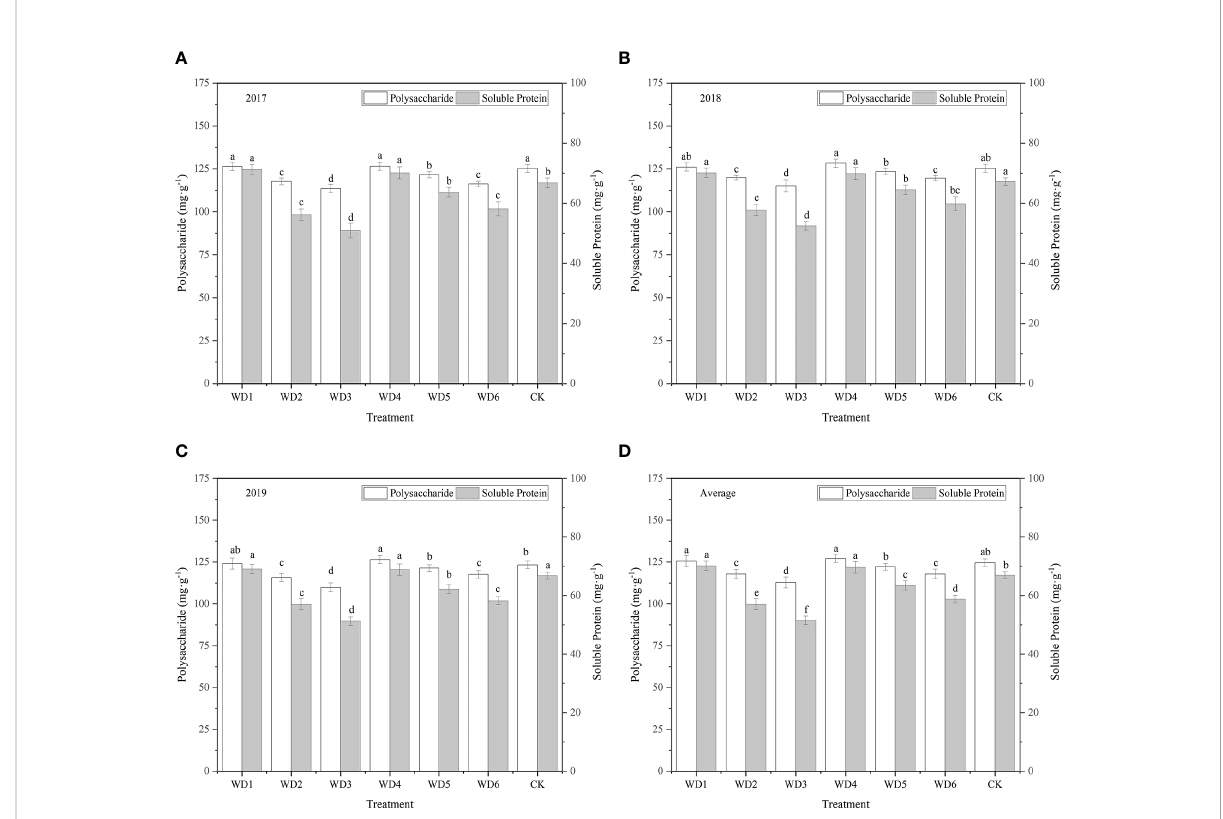
FIGURE 12 Polysaccharide and soluble protein contents of I. indigotica plants in different water de fi cit treatments. (A – D) describe the polysaccharide and soluble protein contents in 2017, 2018, 2019, and the average of these three years, respectively. Different lowercase letters in the same column indicate signi fi cant differences ( P < 0.05). Data were presented as mean ± SE (n =